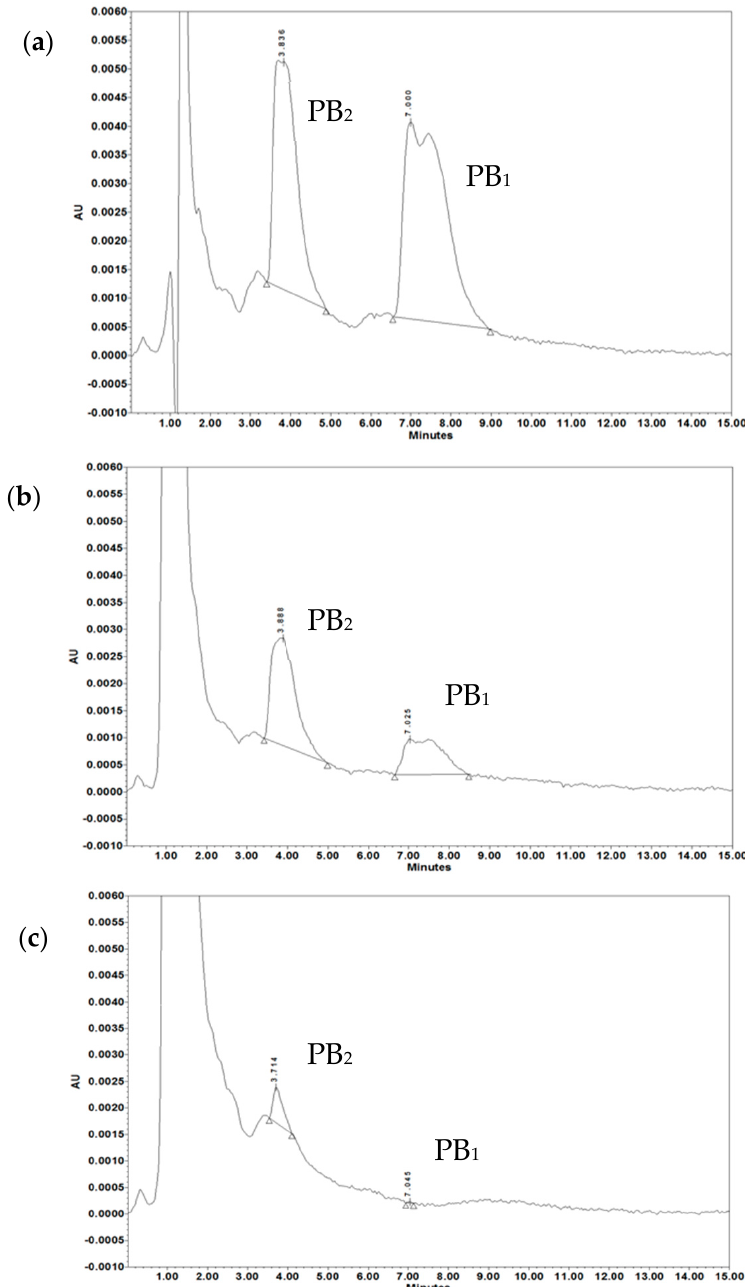
Figure 6. The HPLC spectra of polymyxin B incubated alone or along with OMVs. Chromatograms of ( a ) 50 µ g / mL solution of polymyxin B, ( b ) 50 µ g / mL of PB after treatment with 5 µ g / mL of Mc6 OMVs, ( c ) 50 µ g / mL of PB after treatment with 20 µ g / mL of Mc6 OMVs. Samples were prepared as described in Materials and Method section. HPLC analyses were performed with Macherey–Nagel Nucleodur C18 Isis column. UV-detection at 215 nm. Double peak with Tr = 3.8 min corresponds mainly to polymyxin PB 2 and PB 3 , and double peak with Tr = 7 min corresponds to polymyxin PB 1 and PB 1 -I. The representative chromatograms are